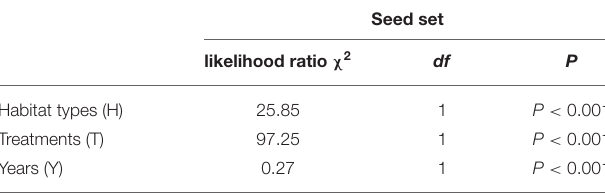
TABLE 3 | Effect of different habitats (grazing and natural), treatments (cross-pollinated and natural pollinated), and years on the seed set of C. microphylla